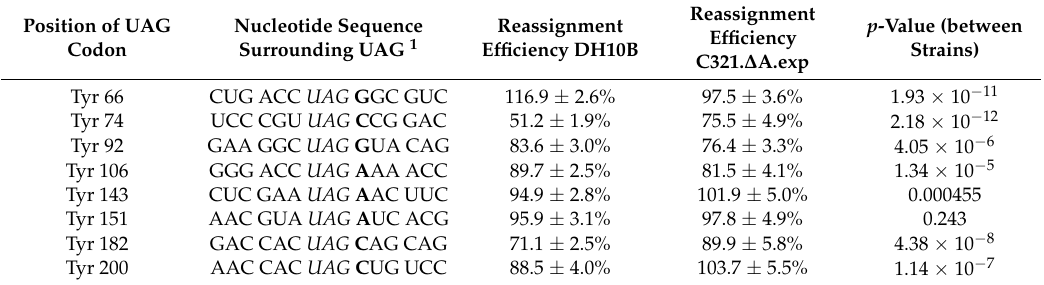
Table 1. Amber stop codon reassignment efficiency for single amber green fluorescent protein (GFP) reporter